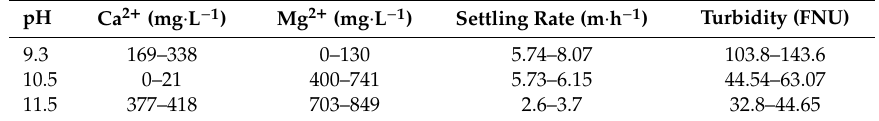
Table 9. Concentration ranges of Ca 2+ and Mg 2 for optimizing the sedimentation process performance at pH of 9.3, 10.5, and 11.5.